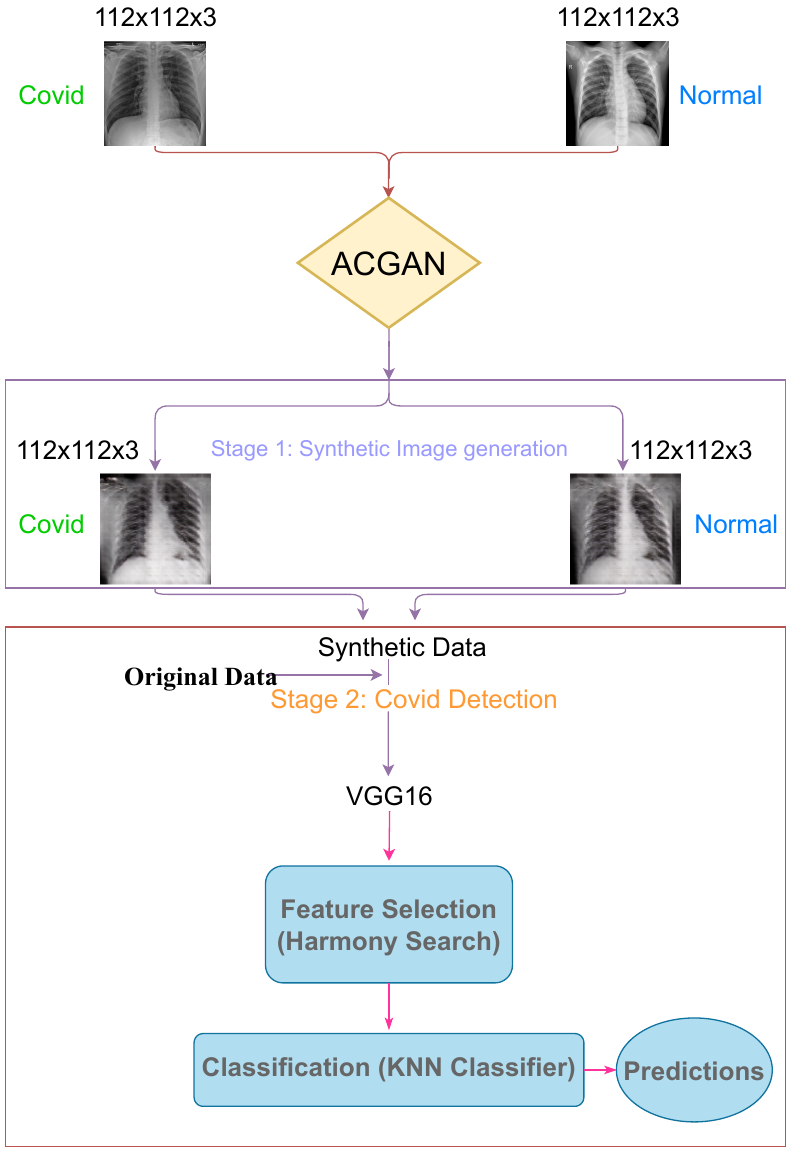
Figure 1. Flowchart representing the overall